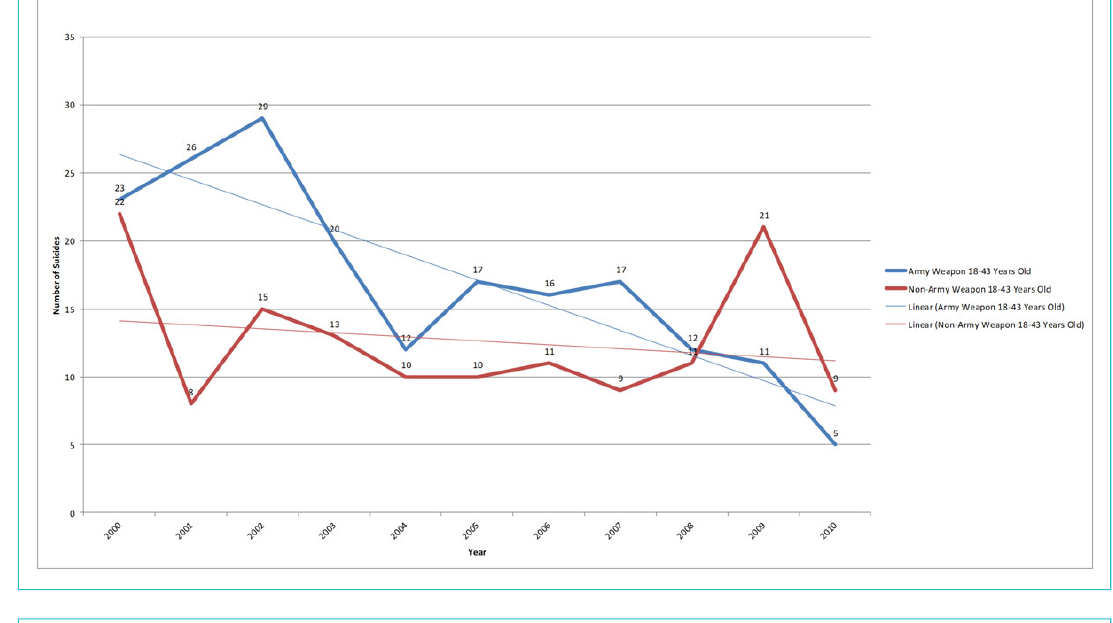
Figure 3: Number of suicides by firearm over time: men over 43 years